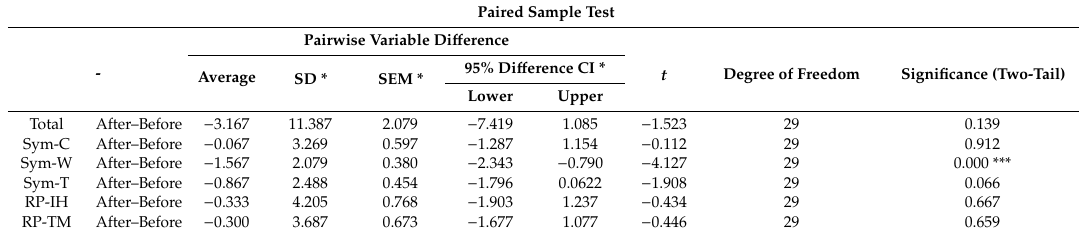
Table 11. Pre- and post-text on di ff erences in Internet addiction. Paired Sample